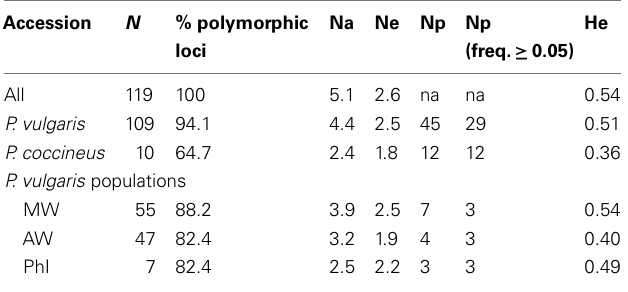
Table 1 | Genetic diversity estimates computed for all of the 17 cpSSR loci considering the whole sample, the P. vulgaris and P. coccineus samples, and the three P. vulgaris populations defined according to the gene